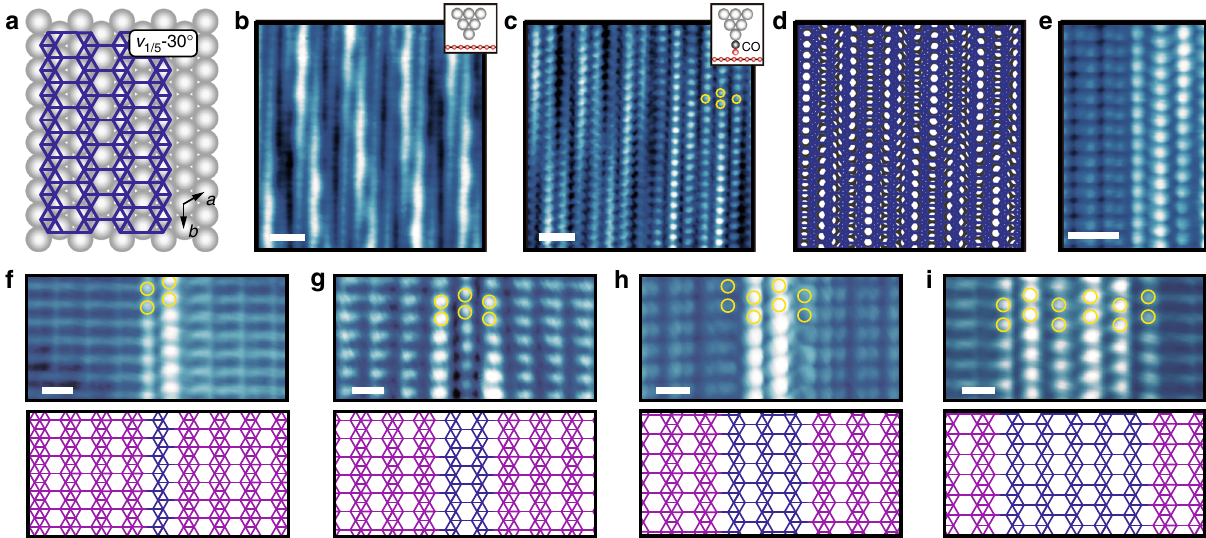
Fig. 3 Resolving v 1/5 − 30° phase borophene and its intermixing with the v 1/6 − 30° phase. a Schematic of v 1/5 − 30° phase borophene. b Bare-tip, and c CO-STM images of undulating v 1/5 − 30° phase borophene. The yellow circles in c indicate the staggered HH pattern. d Schematic of the undulations resulting from a lattice mismatch between borophene and Ag(111). e CO-STM image of the phase boundary between v 1/6 − 30° (left) and v 1/5 − 30° phase borophene. f – i CO-STM images of v 1/5 − 30° line defects in v 1/6 − 30° phase borophene with different widths. The yellow circles denote the staggered arrangement of the HH patterns, with the corresponding structure schematics provided in the bottom row. V s = − 3 mV in b , c , − 7 mV in e , f , − 1 mV in g , 4 mV in h , and − 7 mV in i . Scale bars, 1 nm in b , c , e , 5 Å in f – i